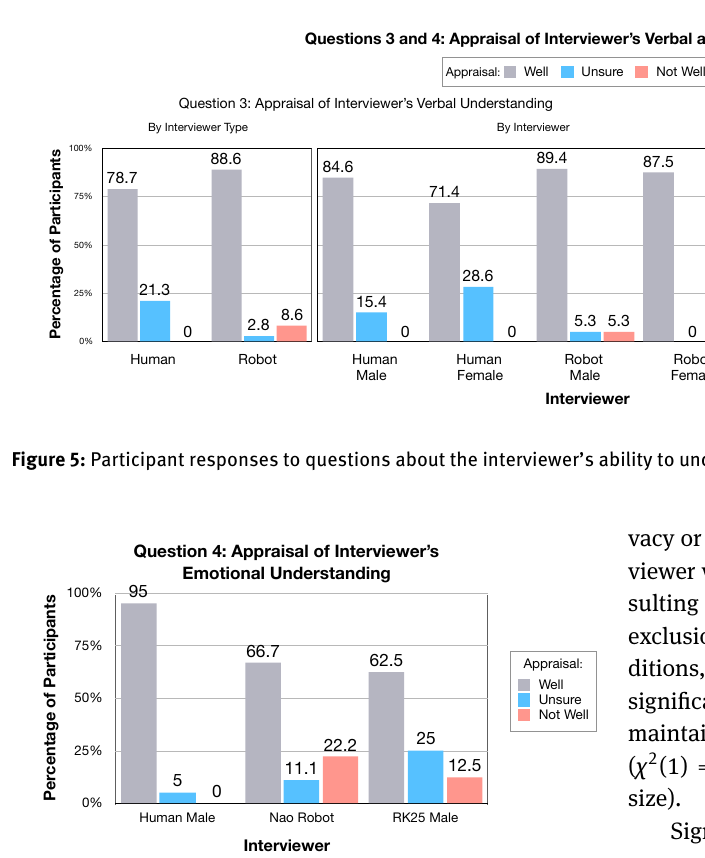
Figure 6: Older participant’s assessment of how well the interviewer understood their feelings, divided by